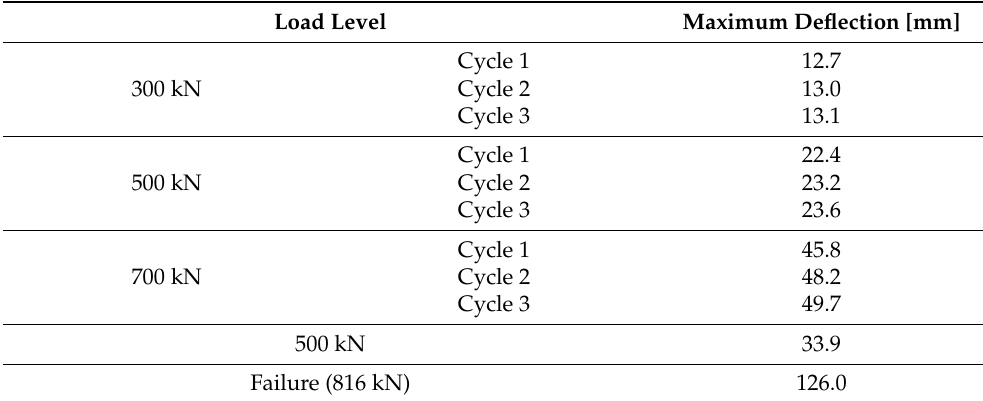
Table 1. Maximum deflection development at the loading point for all load cycles.